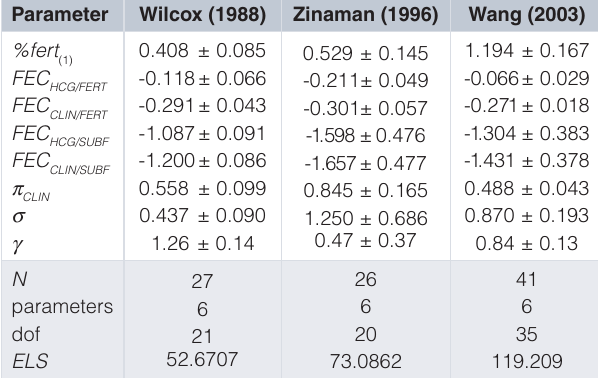
Table 1. Parameter values and statistical output from best fit models ( Model 0 ) of the data from Wilcox (1988), Zinaman (1996) and Wang (2003) studies. Probabilities and percentages were estimated as logits (base 10). Standard errors are shown.